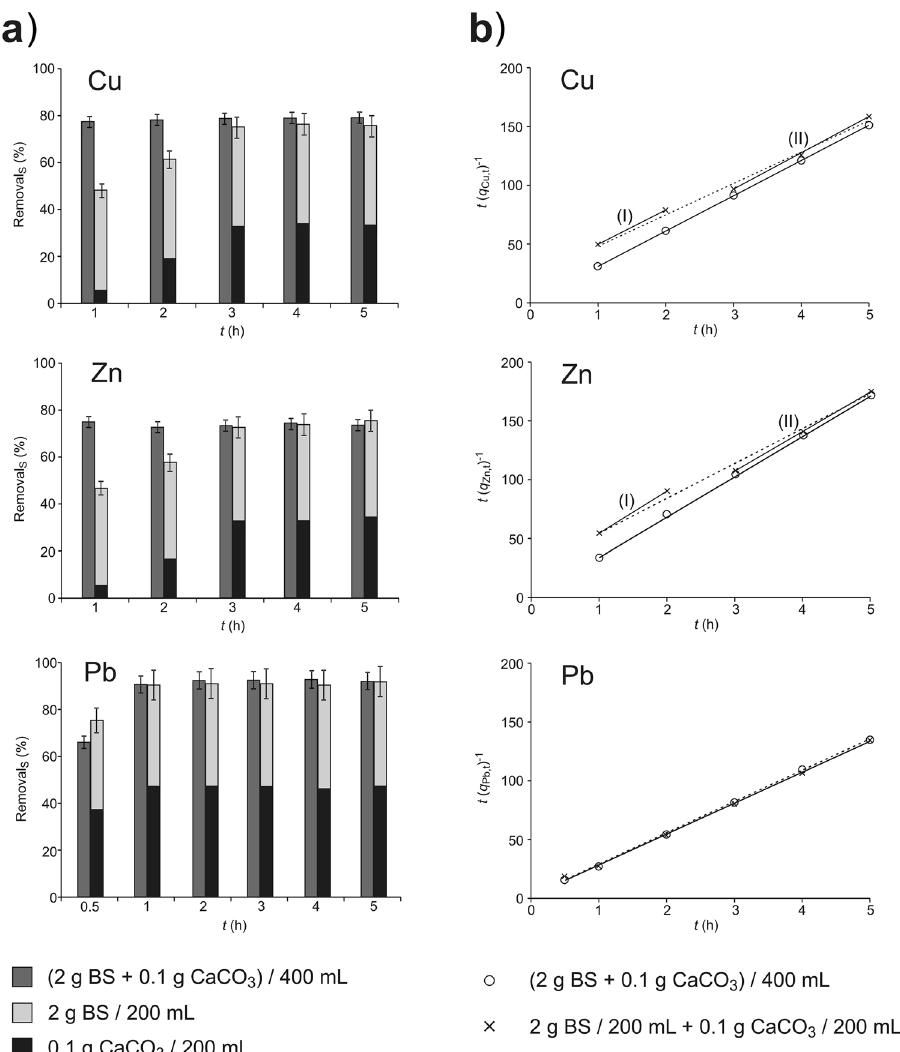
Figure 2. Kinetics of removal of metal cation using spelt husks and CaCO 3 in variants: together gray, and separately light gray, dark gray, described by: ( a ) removal efficiency depending on the contact time, ( b ) pseudo- second-order reaction model.